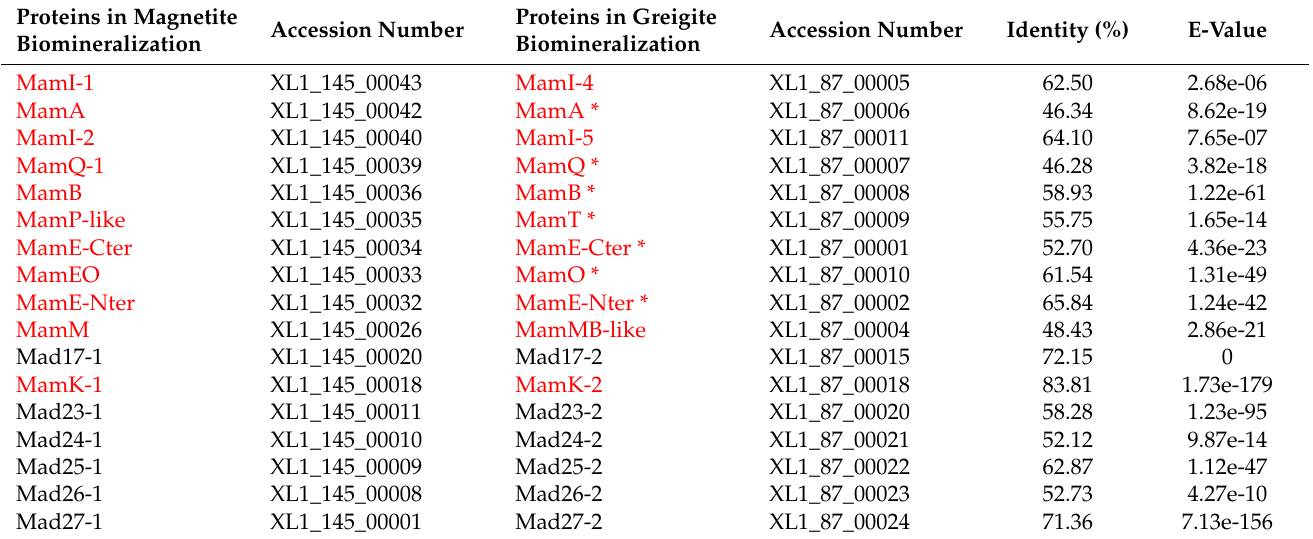
Table 1. Comparison of Mam and Mad proteins putatively controlling the biomineralization of magnetite and greigite magnetosomes of MMP